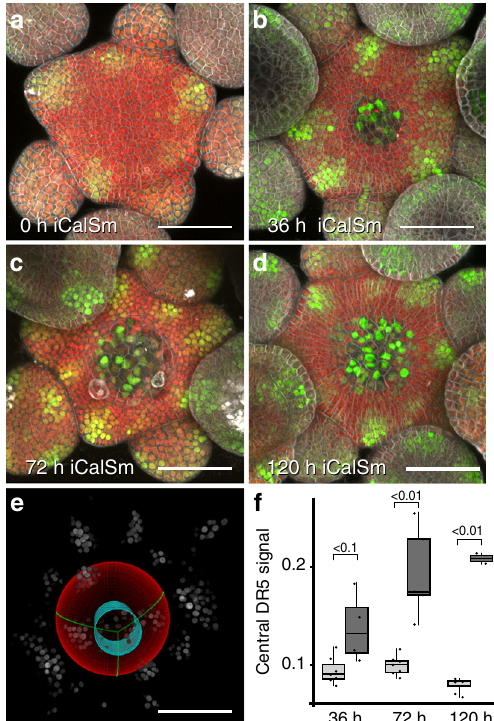
Fig. 2 The central auxin signaling minimum is dependent on stem cell fate. a – d pDR5v2:3xVENUS-NLS activity after stem cell speci fi c induction of iCalSm. Stem cell differentiation is marked by loss of pRPS5a:NLS-tdTomato . Independent channels and Z-projections are shown in Supplementary Fig. 1. e Computational sphere fi tting and identi fi cation of the central zone for fl uorescence signal quanti fi cation (see Supplementary Fig. 2). f Quanti fi cation of DR5v2 signal intensity in the central zone across the experimental cohort described in Supplementary Fig. 2. Light gray boxes represent uninduced controls, dark gray boxes represent plants induced with 1% ethanol. Individual analyzed SAMs are indicated as dots. Analysis of variance (ANOVA) showed signi fi cant variation between control and induced samples. Post hoc Turkey test p values are shown. Scale bars: 50 µ m. See also Supplementary Fig.